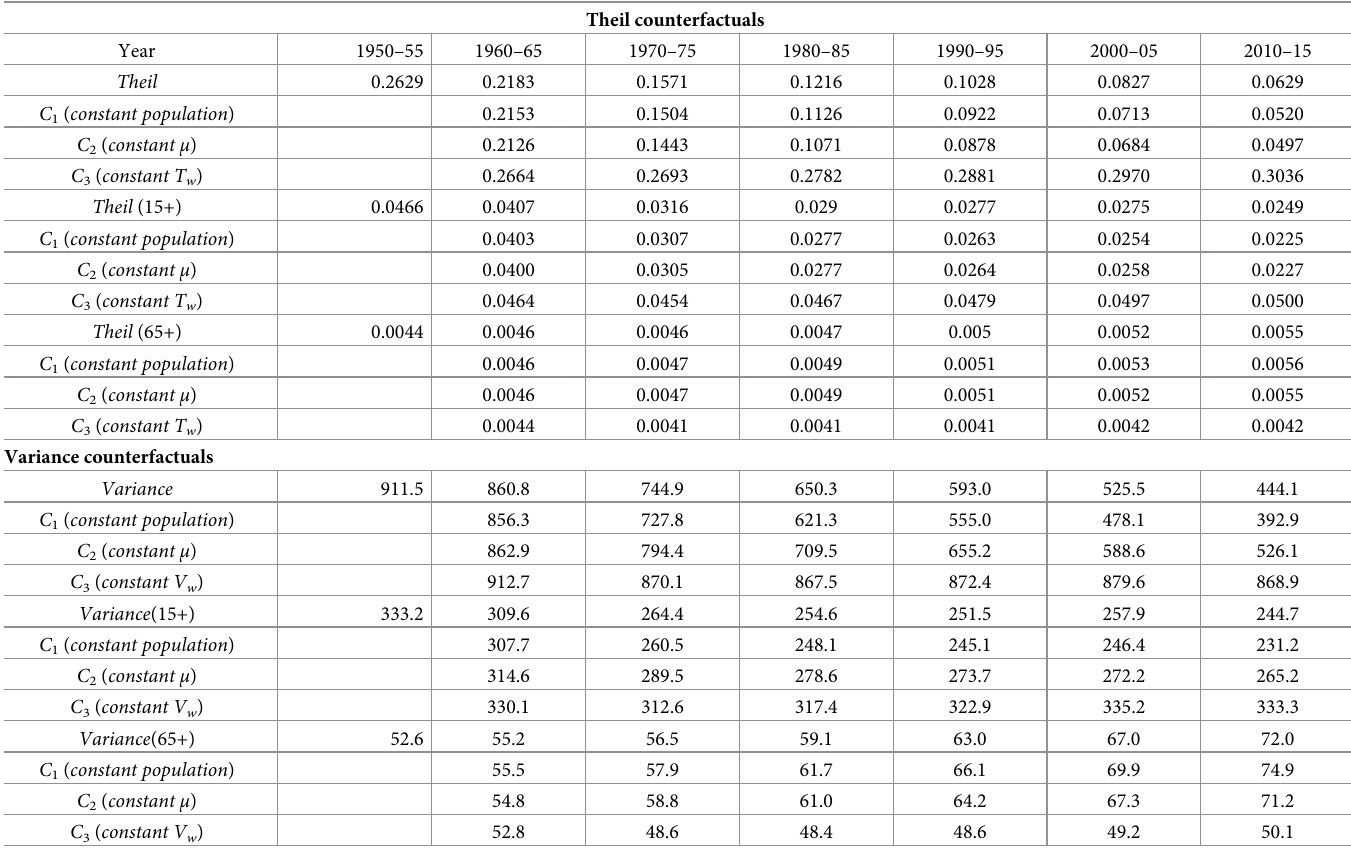
Table 2. Counterfactual analyses for the Theil index and the